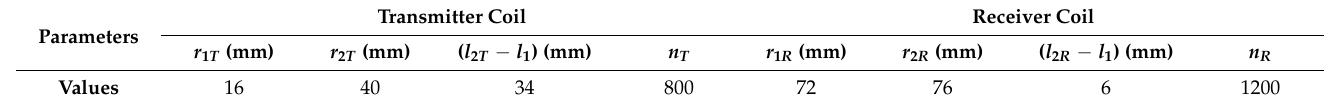
Table 1. Parameters of the sensor.